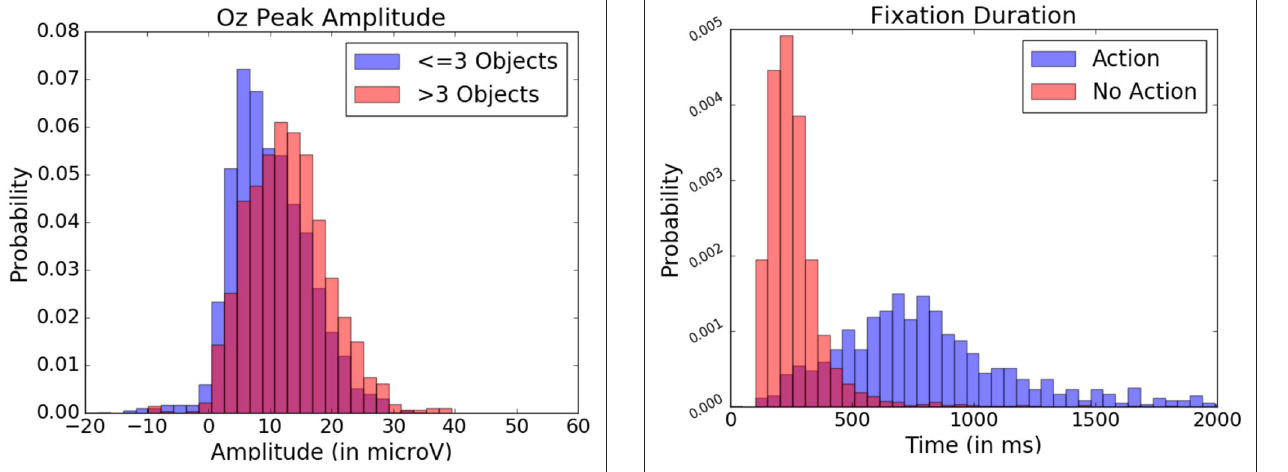
FIGURE 11 | Peak amplitude variation depending on the quantity of objects within the visual fixation region. Data from one participant was used in this figure.